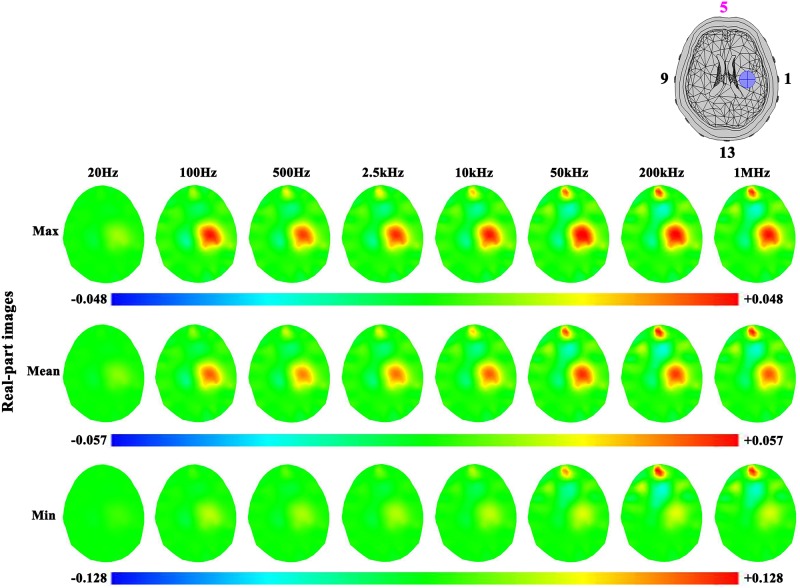
Real-part images of the ischemic stroke lesion and the effects of three levels of contact impedance (The reference frequency was 10 Hz).The physical unit of color bar is S/m in this study.